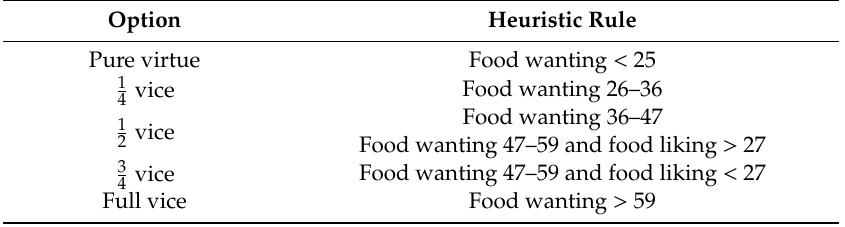
Table 7. Heuristic rules for predicting food choice considering food reward